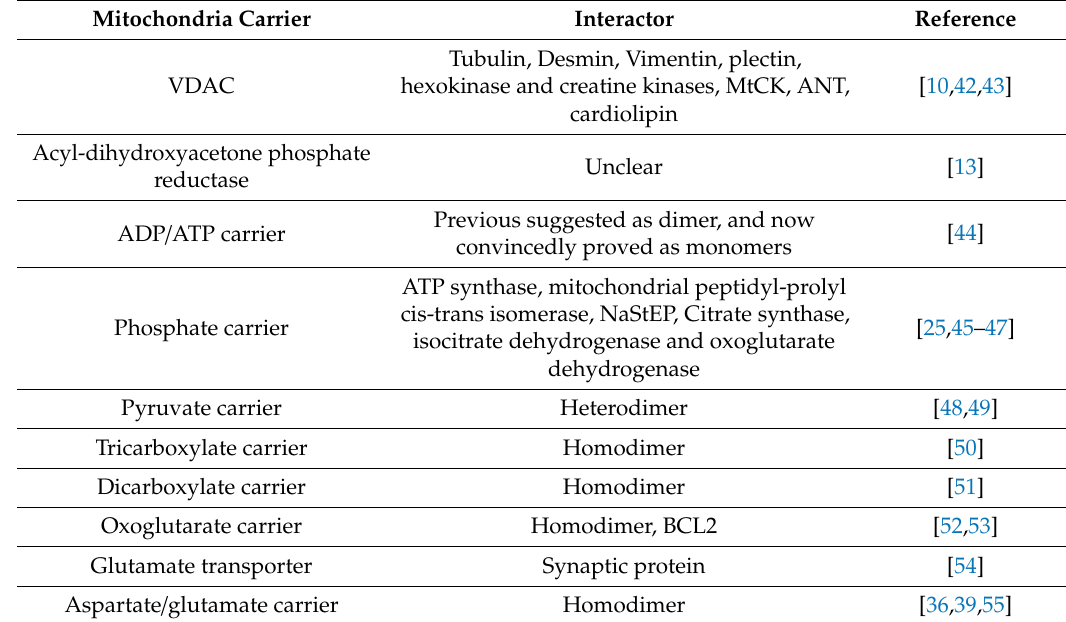
The interactome of mitochondrial carrier family members and other mitochondrial transporter